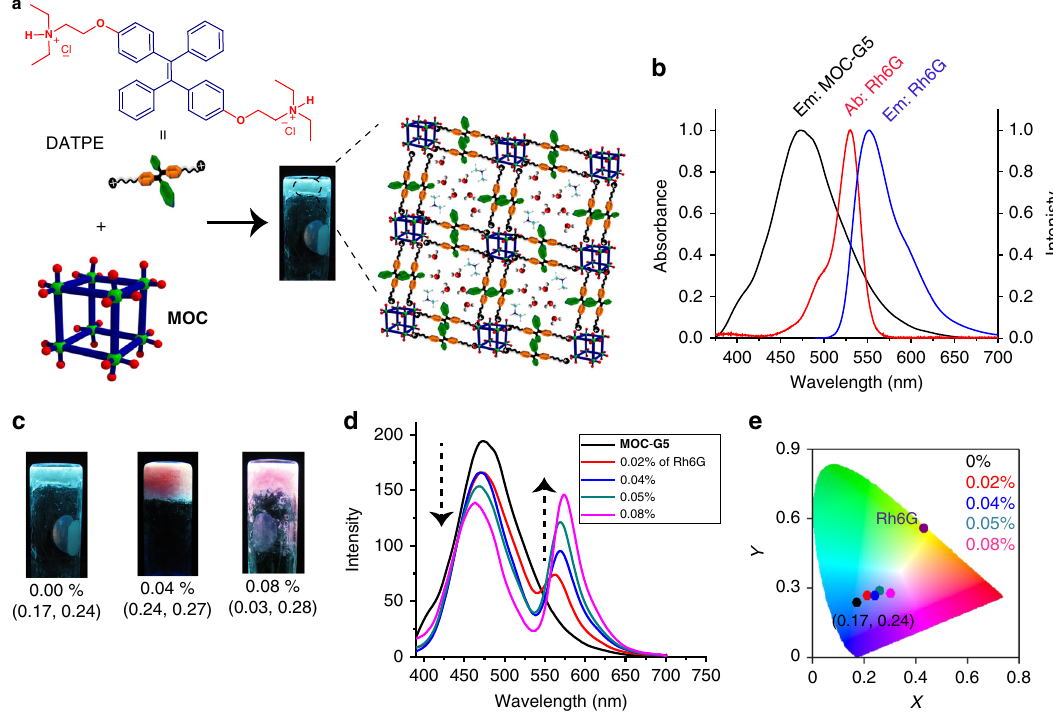
Fig. 5 Luminescent MOC - G5 hydrogel as an energy transfer scaffold. a Schematic showing self-assembly of MOC and DATPE to MOC-G5 hydrogel which shows blue emission under UV light. b Emission spectrum of MOC - G5 (black), absorption (red) and emission (blue) spectrum of Rh6G in solution. c Images of MOC - G5 hydrogels with various loading of Rh6G (images are taken under UV lamp) and their corresponding CIE coordinates (mentioned below). d Emission spectra of MOC - G5 hydrogels loaded with different amounts of Rh6G (arrows indicate changes) and e corresponding chromaticity diagram showing the CIE coordinates of the hybrid